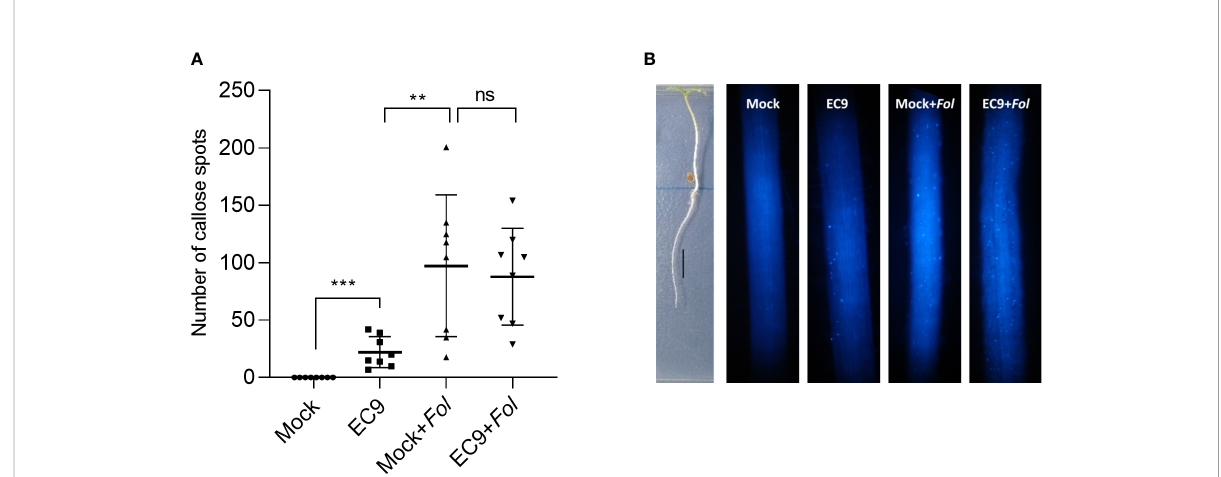
FIGURE 5 B cereus EC9 induces callose deposition in tomato roots. (A) Number of the callose spots in roots (cv. Moneymaker) (n=8-10) 24 hours post- inoculation. (B) Representative images of tomato roots of 7 days old tomato plants, grown on ½ x MS medium positioned vertically, treated with EC9 or mock and inoculated with Fol at 24 hours post-treatment. Presence of callose spots were visualized by aniline blue staining and fl uorescence microscopy. ns non-signi fi cant, ** P < 0.01, *** P < 0.001. Data points correspond to the mean ± standard error. Experiments were repeated two times with similar